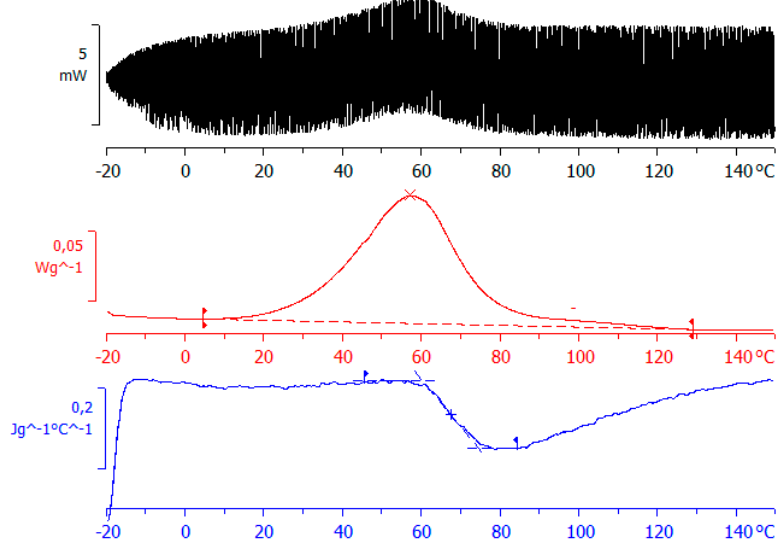
Figure 5. TOPEM thermogram for ELP25000 at an underlying heating rate of 0.5 °C/min: top diagram shows the stochastically modulated heat flow; middle diagram shows the total heat flow; bottom diagram shows the “quasi-static” specific heat capacity, c p0 .